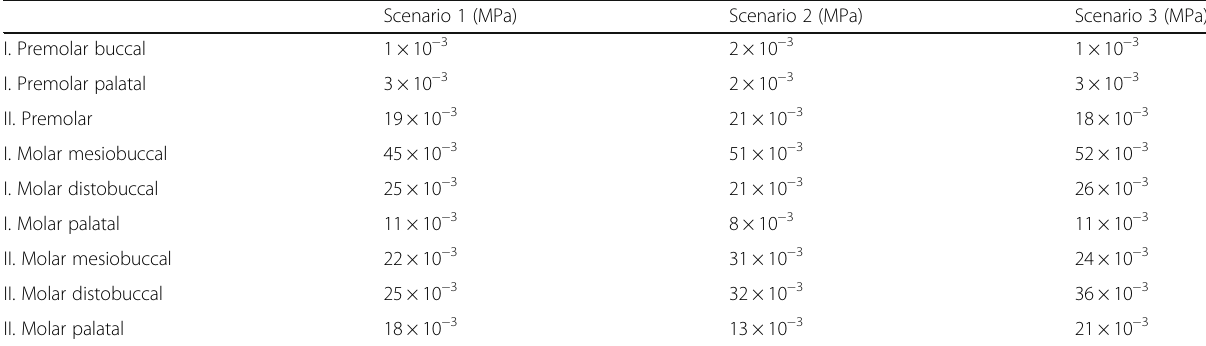
Table 5 Von Mises stress values for the root